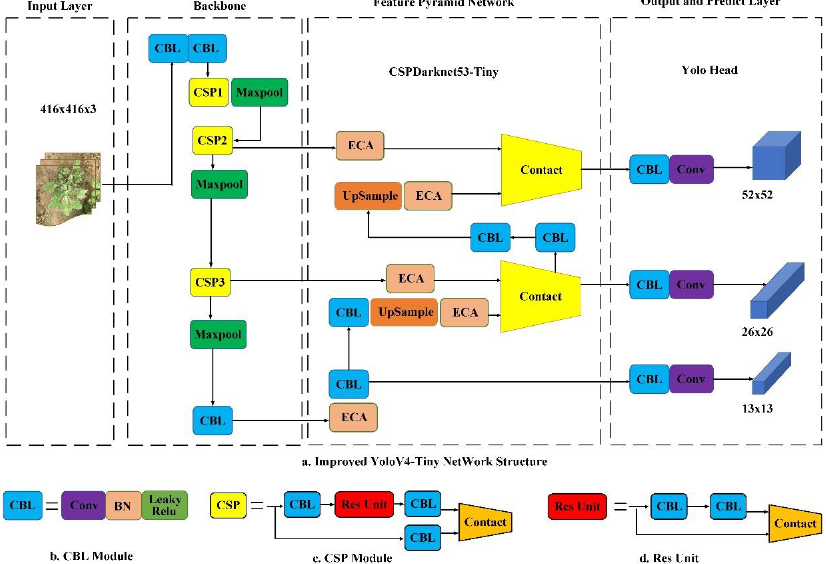
Figure 3. EM-YOLOv4-Tiny network Structure, where Conv is convolution, BN is batch normaliza- tion, Leak Relu is activation function, Maxpool is maximum pooling, ResUnit is the residual unit, Upsample is upsampling, ECA is efficient channel attention module, Contact is the feature fusion method of adding channel numbers, Yolo Head is the prediction anchor, CBL is series fusion module of Conv, BN, and Leak Relu, and CSP is cross-stage partial